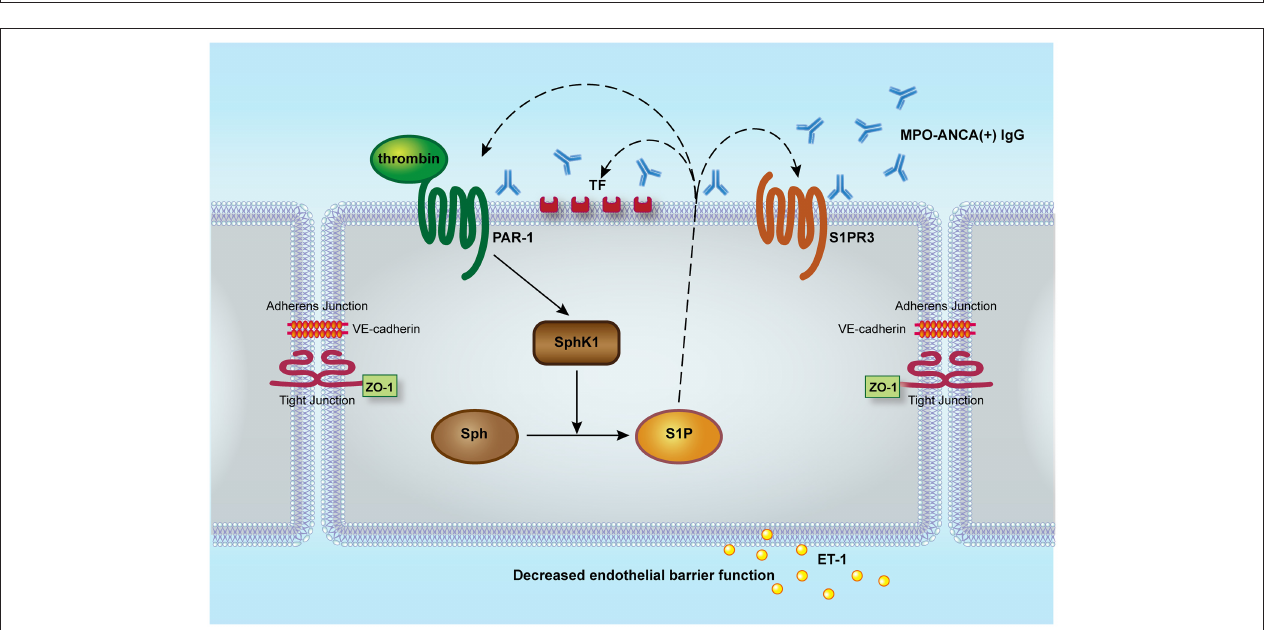
FIGURE 5 | S1P enhanced the expression and activity of TF in GEnCs in the presence of MPO-ANCA-positive IgG. (A) S1P enhanced the expression levels of TF in GEnCs in the presence of MPO-ANCA-positive IgG. (B) S1P enhanced the procoagulant activity of TF in GEnCs in the presence of MPO-ANCA-positive IgG. Bars represent mean ± SD of repeated measurements of five independent experiments or donors. * P < 0.05, *** P < 0.001.